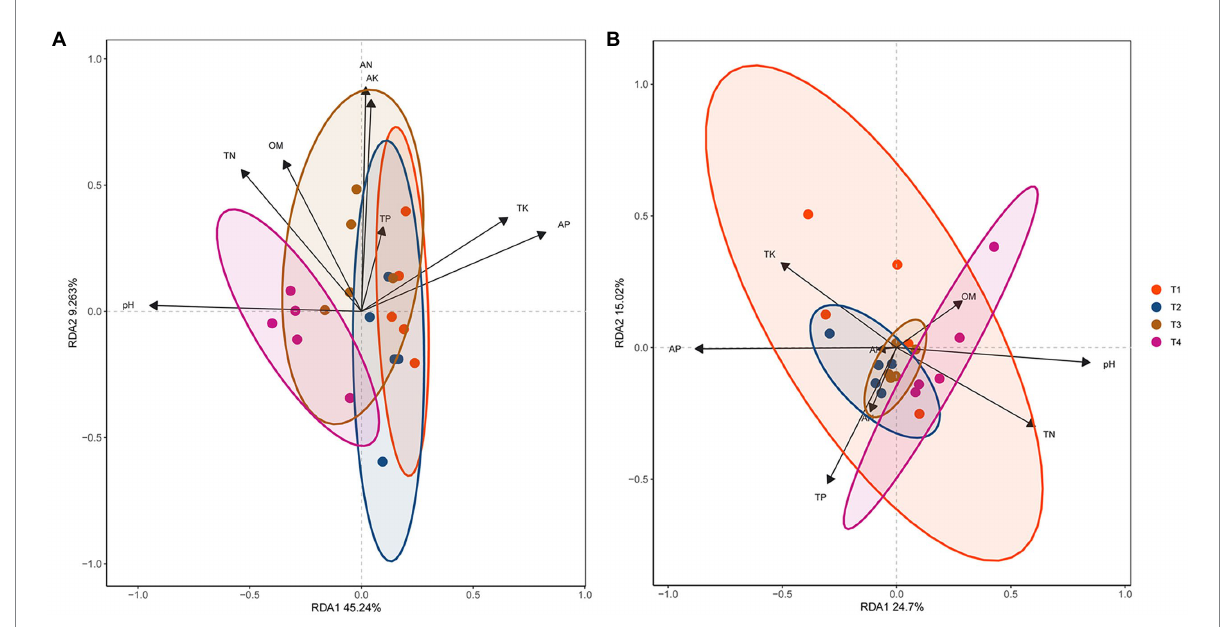
FIGURE 5 Redundancy analysis (RDA) of relative abundances of dominant bacterial and fungal phyla and the physicochemical properties in soil collected at the harvest stage. RDA analysis was performed using the Tutools platform (https://www.cloudtutu.com) at 95% confidence interval. The arrow length represents the strength of the correlation between the soil microorganisms and physicochemical properties. Longer arrows indicate stronger correlations. The perpendicular distance between the soil microorganisms and physicochemical properties axes reflects their correlations, and the smaller distance indicates a stronger correlation. T1, soil treated with R. palustris PSB-06 and dazomet. T2, soil treated with dazomet alone. T3, soil treated with R. palustris PSB-06 alone. T4, soil without treatment (blank control). pH, potential of hydrogen; OM, organic matter; TN, total nitrogen; AN, hydrolytic nitrogen; TP, total phosphorus; AP, available phosphorus; TK, total potassium; and AK, available